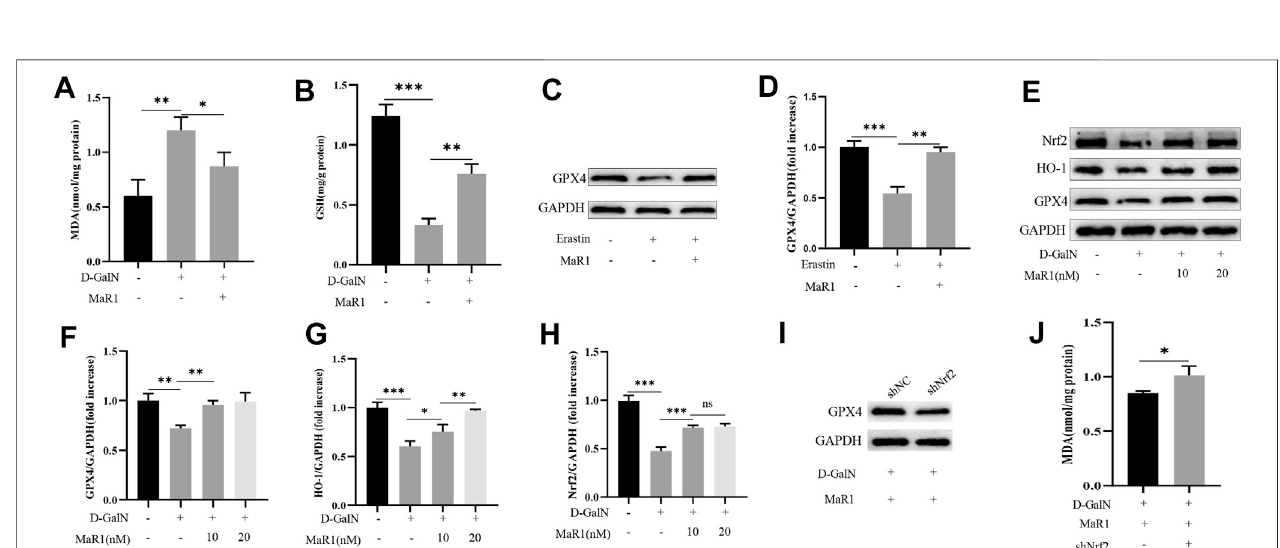
FIGURE 6 | MaR1 suppressed D-GalN-induced and erastin-induced ferroptosis in vitro . (A) D-GalN signi fi cantly increased the MDA content, while MaR1 administration reduced theMDA content. (B) Thetest ofGSH content inthecells. (C,D) Erastinsigni fi cantlyreduced theexpression ofGPX4, whileMaR1 promoted the expressionofGPX4. (E – H) MaR1promotedtheexpressionofNrf2,HO-1,andGPX4. (I) WhenNrf2wasknockeddown,theexpressionofGPX4signi fi cantlydecreased. (J) The level of MDA signi fi cantly increased in knock-down group. Data are shown as the mean ± SD, * p < 0.05; ** p < 0.01; *** p <